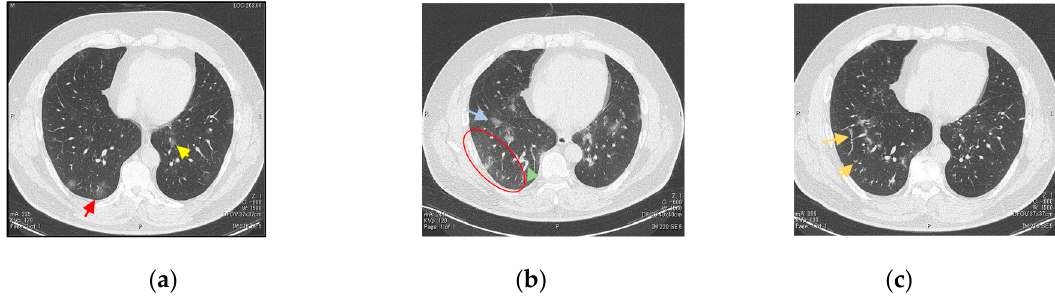
Figure 1. Computed tomography (CT) findings of the patient’s lungs at days 0, 3, and14. ( a – c ) CT images of the patient’s lungs at day 0 ( a ), day 3 ( b ), and day 14 ( c ). Red and yellow arrows in ( a ) indicate bilateral ground-glass opacities (GGOs) with a peripheral and posterior predominance, respectively. Red circle in ( b ) indicates an increased number of bilateral GGOs that are widespread in the lungs. Blue and green arrows in ( b ) indicate a reticular pattern and the appearance of dilated vessels, respectively. Orange arrows in ( c ) indicate GGOs that have shrunk, changed into a small consolidation, or developed a cord-like appearance.